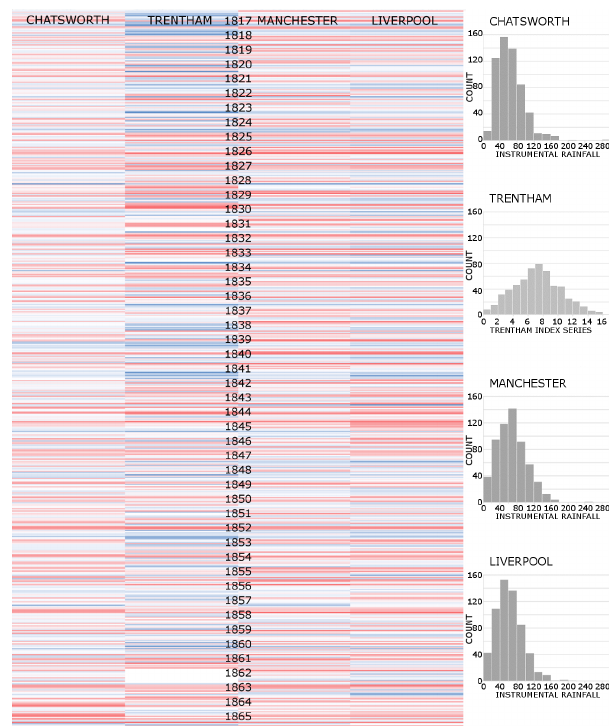
Figure 6. Wet (blue) and dry (red) months August 1816– December 1865, with distribution (note data for 1862 at Trentham are